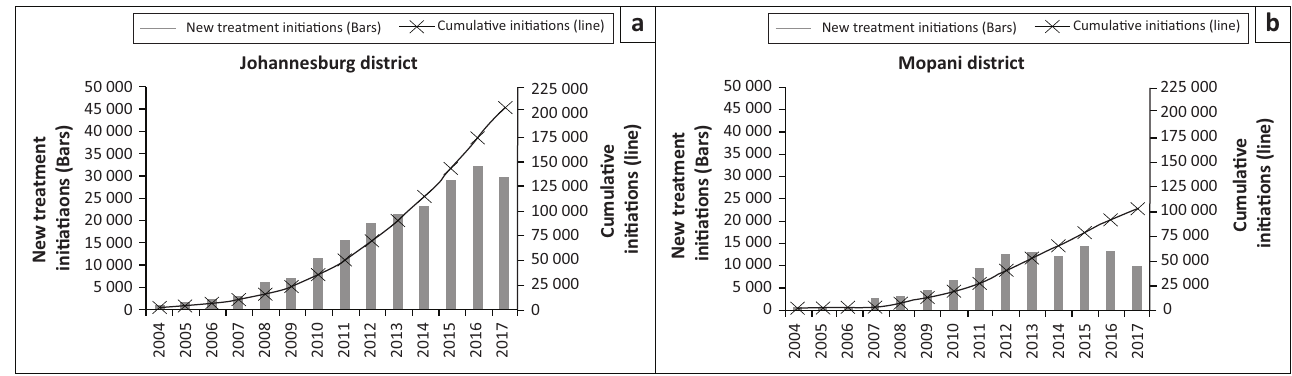
FIGURE 1: Antiretroviral therapy initiations over time among adult clients newly initiating treatment in (a) Johannesburg district and (b) Mopani